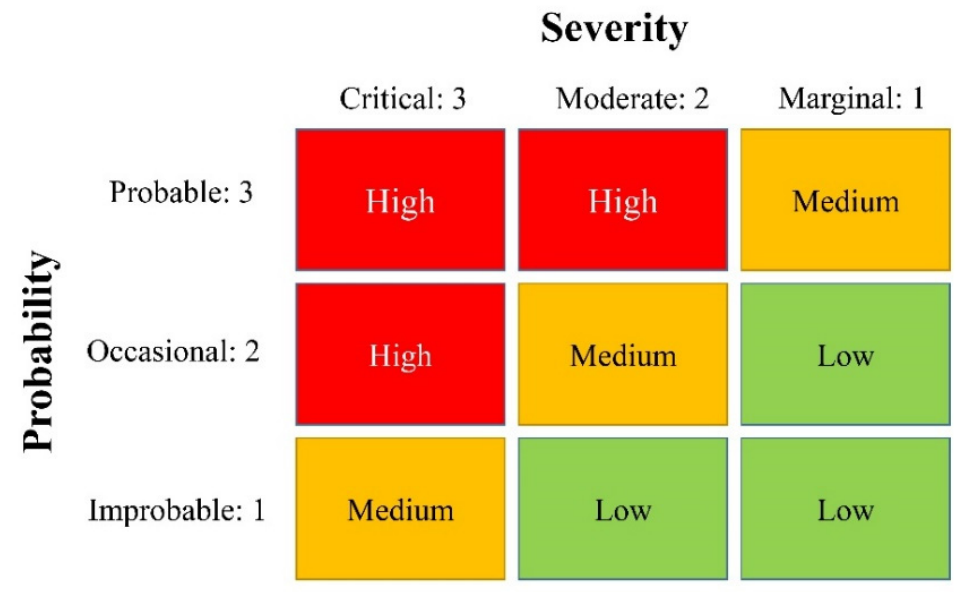
Figure 5. Three-level risk matrix.